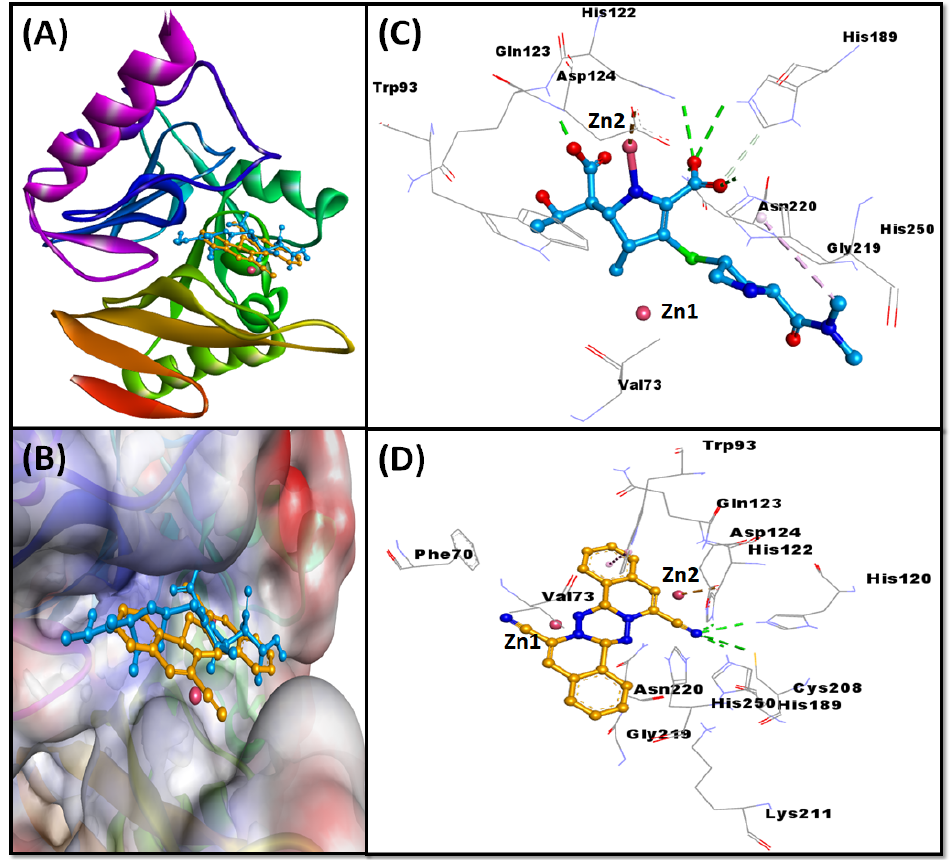
Figure 2. Molecular docking of NDM-1 with meropenem and MCULE-8777613195-0-12. ( A ) Binding of meropenem to the substrate binding site of NDM-1; ( B ) 3D representation of the interaction between NDM-1 and meropenem; ( C ) binding of MCULE-8777613195-0-12 to the substrate binding site of NDM-1; ( D ) 3D representation of the interaction between NDM-1 and MCULE-8777613195-0-12. Table 2. Molecular docking parameters of shortlisted ligands and NDM-1 interaction.